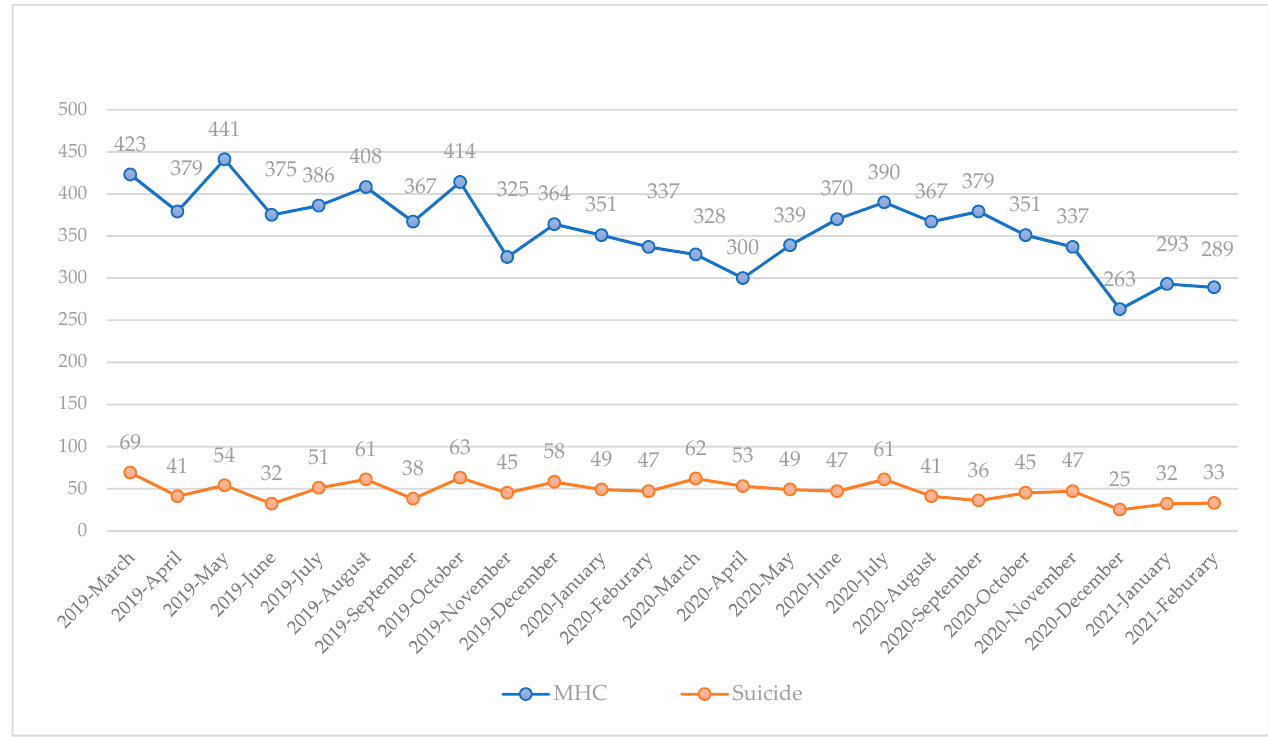
Figure 2. Monthly trends in patients experiencing MHCs who used EMSs before and during the COVID ‐ 19 pandemic. MHC, mental health crisis; EMS, emergency medical service. The Y ‐ axis on the left is the number of patients experiencing MHCs who used EMSs.